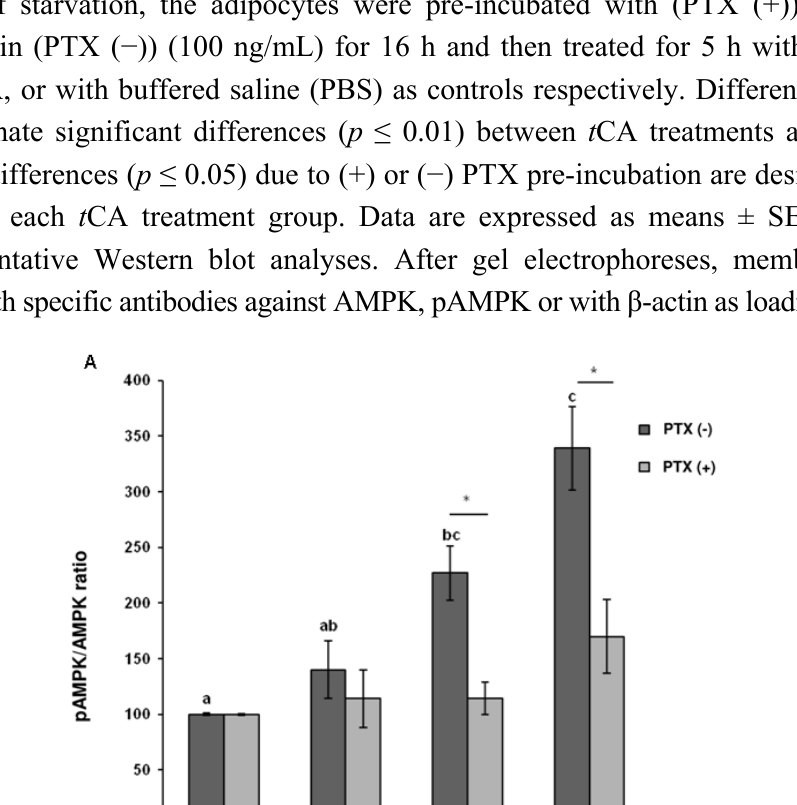
Figure 1. Trans -cinnamic acid ( t CA) affects the intracellular 5'adenosine monophosphate- activated protein kinase (AMPK) activation by phosphorylation (pAMPK) in differentiated 3T3-L1 cells. ( A ) t CA effects on pAMPK/AMPK ratios in differentiated 3T3-L1 cells. After 4 h of starvation, the adipocytes were pre-incubated with (PTX (+)) or without pertussis toxin (PTX ( − )) (100 ng/mL) for 16 h and then treated for 5 h with 80, 250 or 750 µM t CA, or with buffered saline (PBS) as controls respectively. Different lower case letters designate significant differences ( p ≤ 0.01) between t CA treatments and